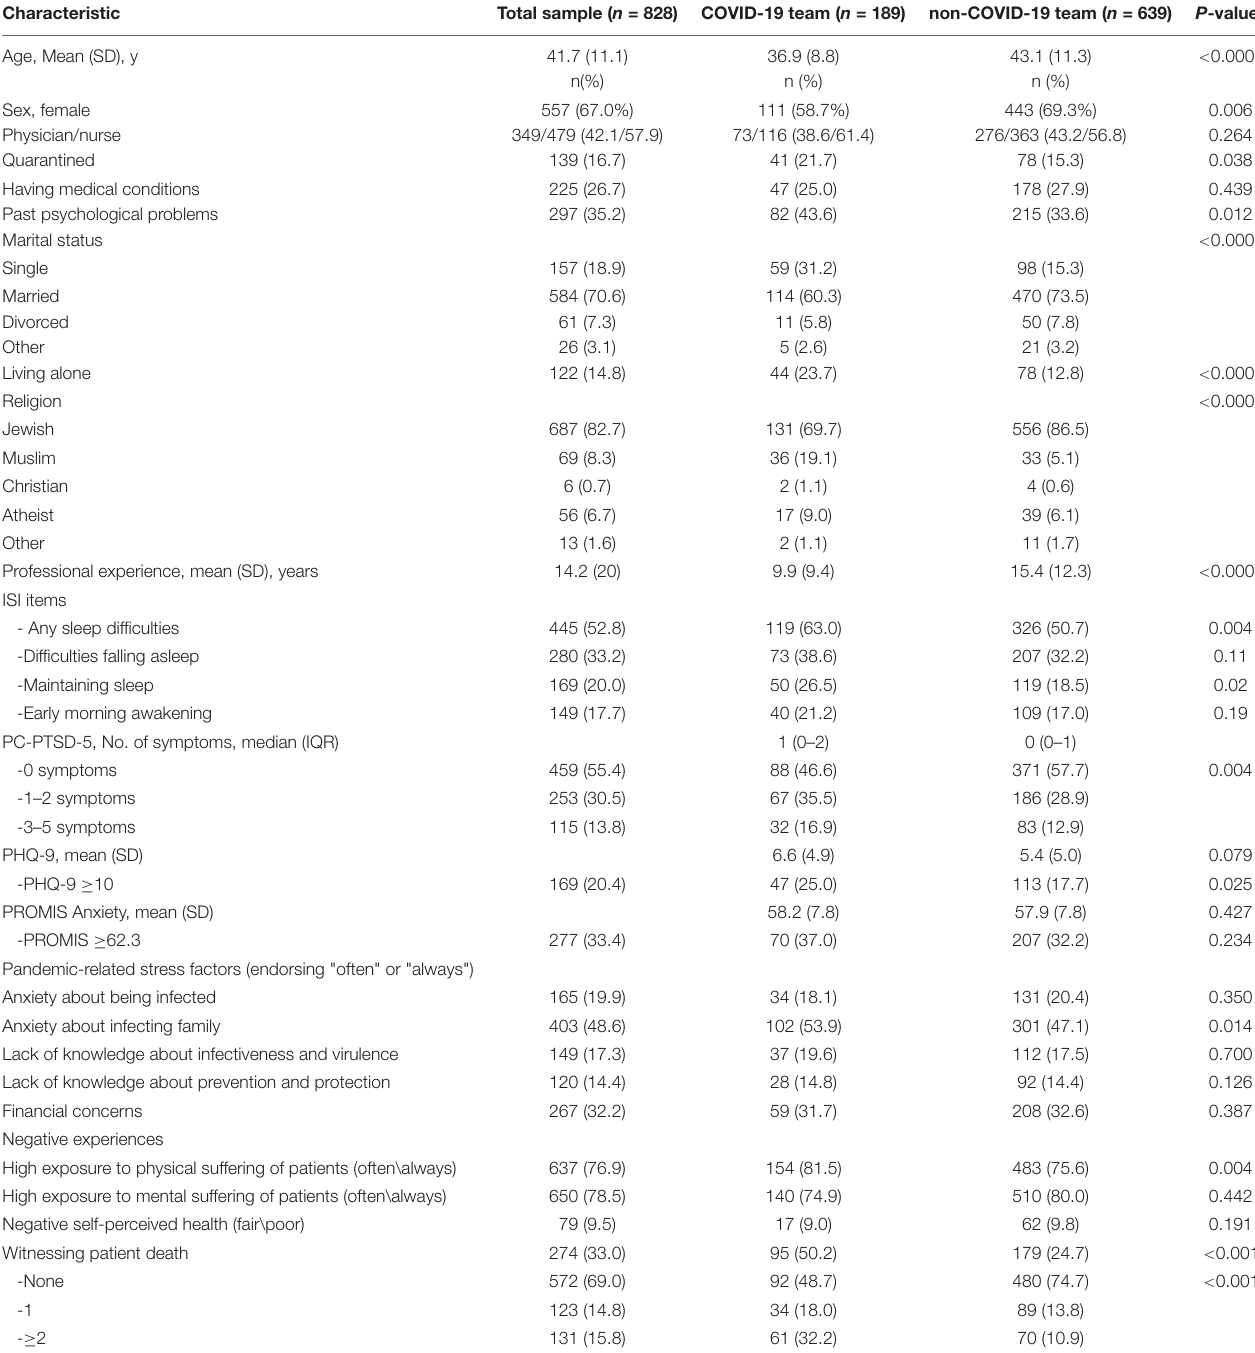
TABLE 1 | Sociodemographic and clinical characteristics of the sample.